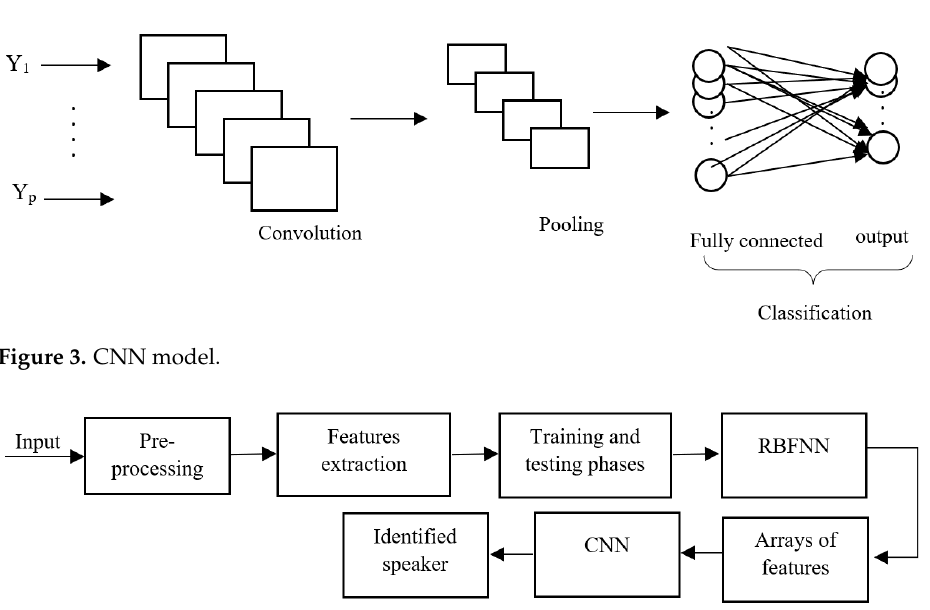
Figure 4. The block diagram of the proposed cascaded model (RBFNN-CNN) under stressful talking conditions.